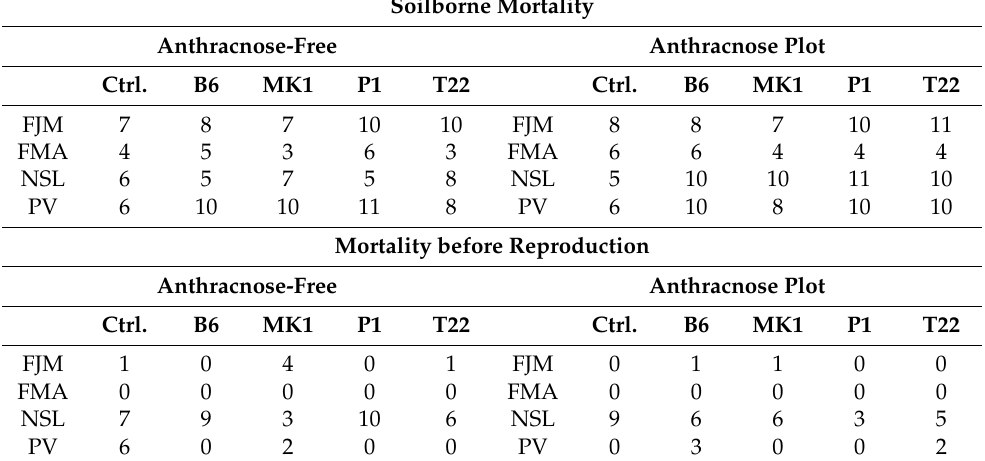
Table 2. Mortality under field conditions.